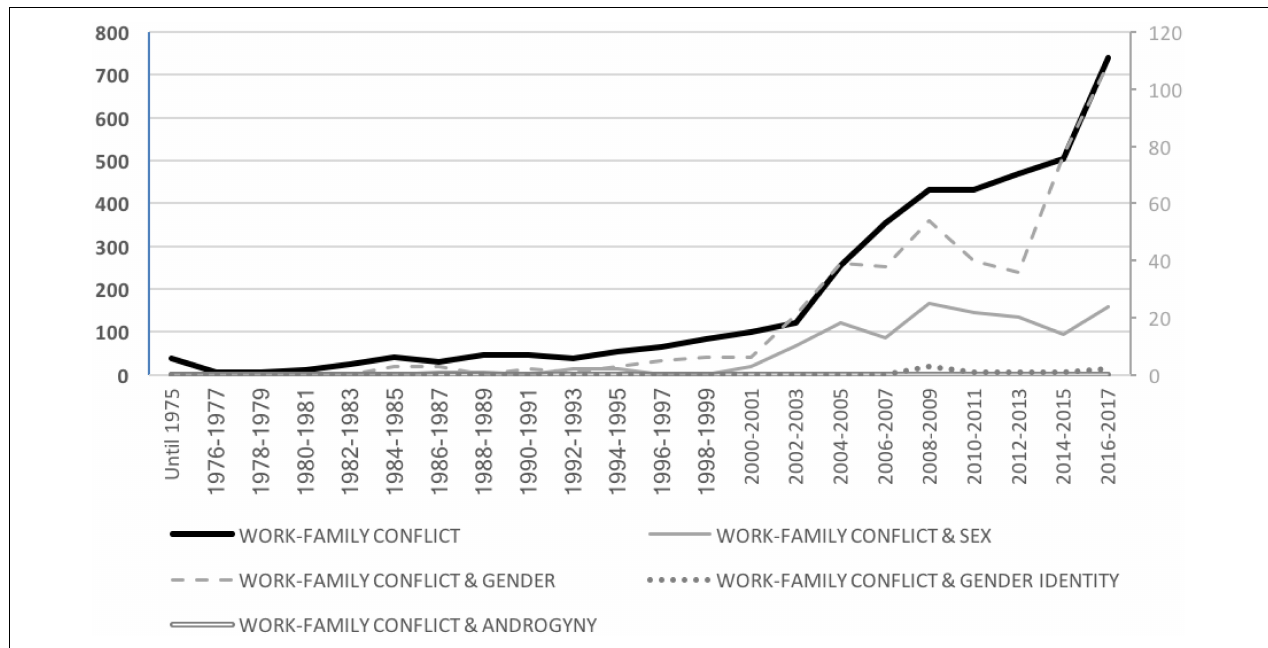
FIGURE 6 | Total number of scientific articles per year about the work–family conflict by gender category.